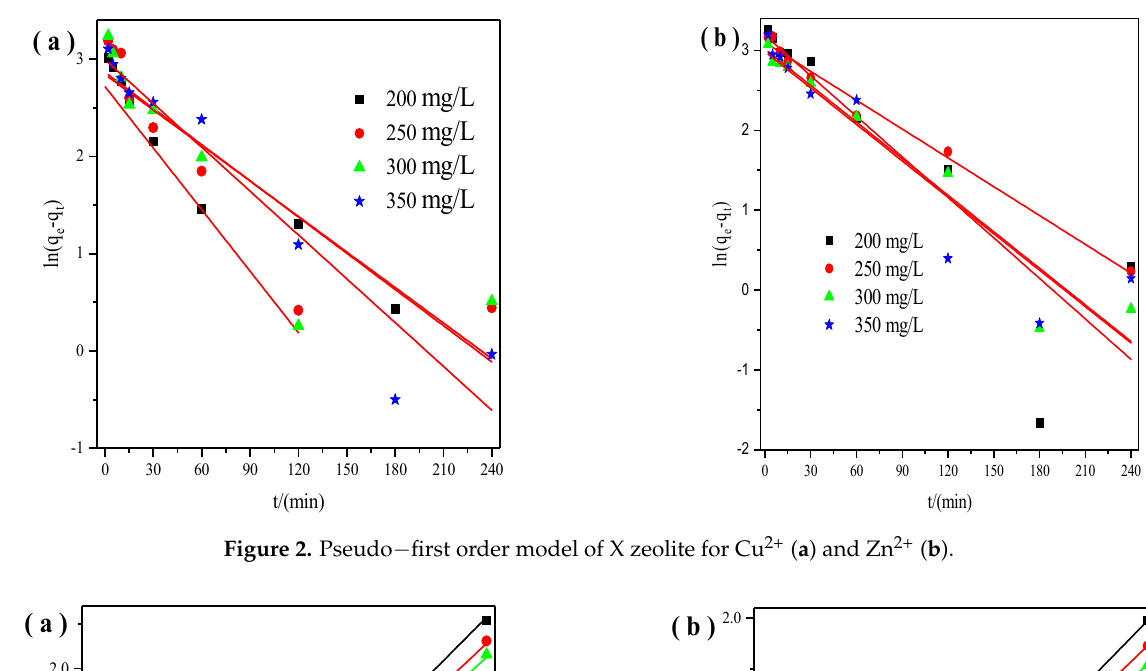
where k 2 (min − 1 ) is the rate constant of pseudo-second-order reaction and h [mg/(g·min)] is the initial sorption rate. The rate constants can be determined via the linear plot t/q t against t (Figure 3).